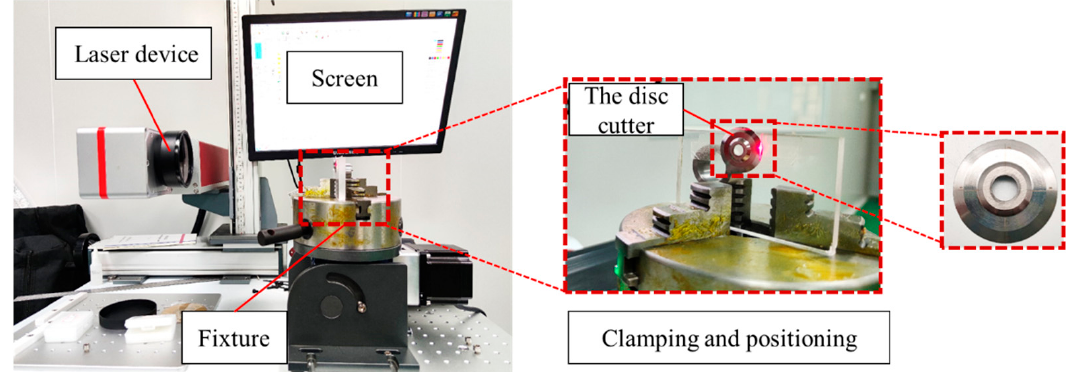
Figure 4. The laser etching platform.